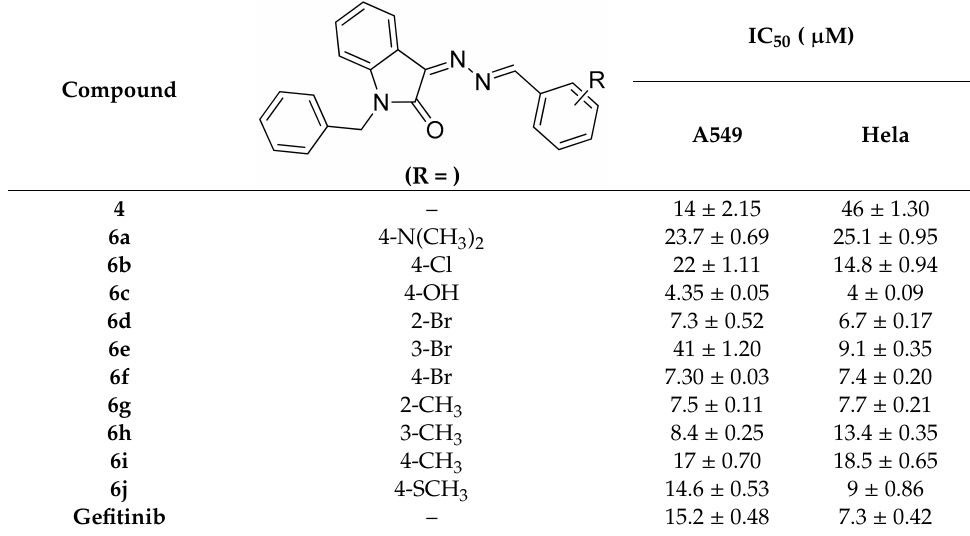
Table 1. Antiproliferative activity of N- benzylisatin-aryl hydrazones ( 6a–j ).